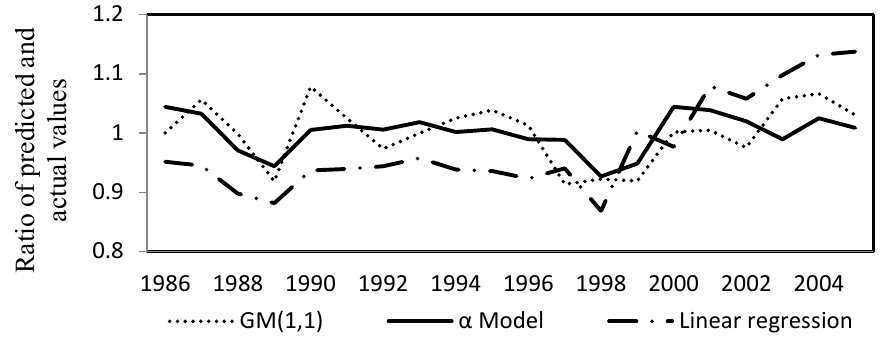
Fig. 2 Ratio of predicted and actual values.